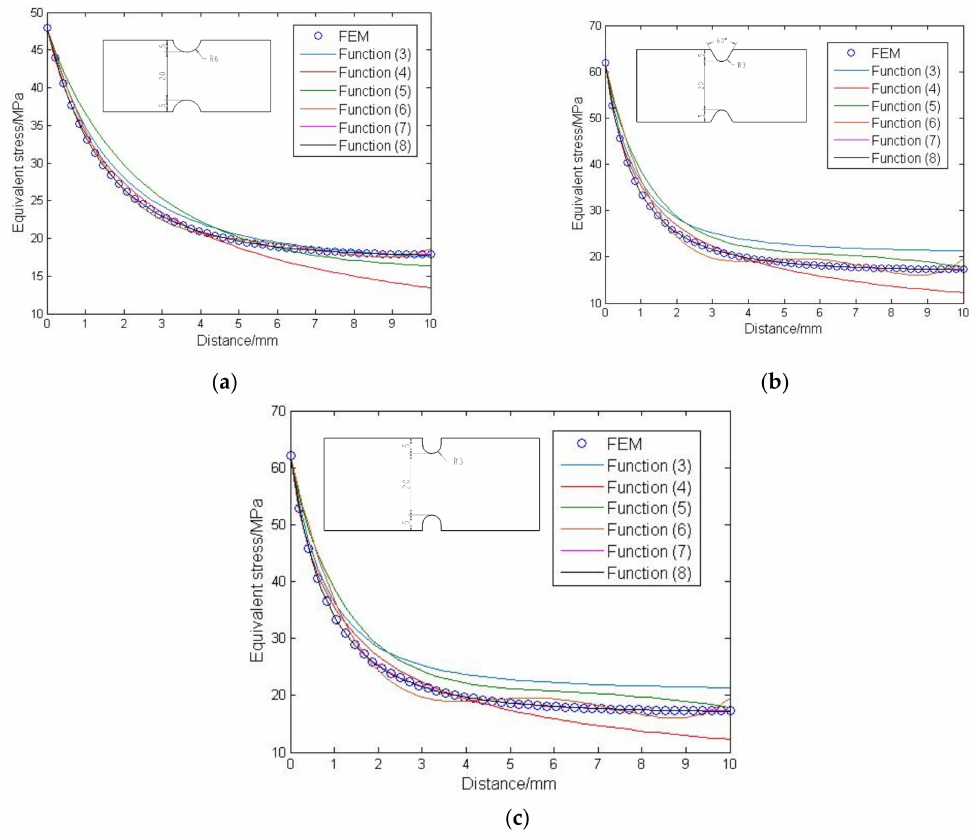
Figure 4. Fitting results of different types of notches: ( a ) semicircular notch; ( b ) V-notch; ( c )